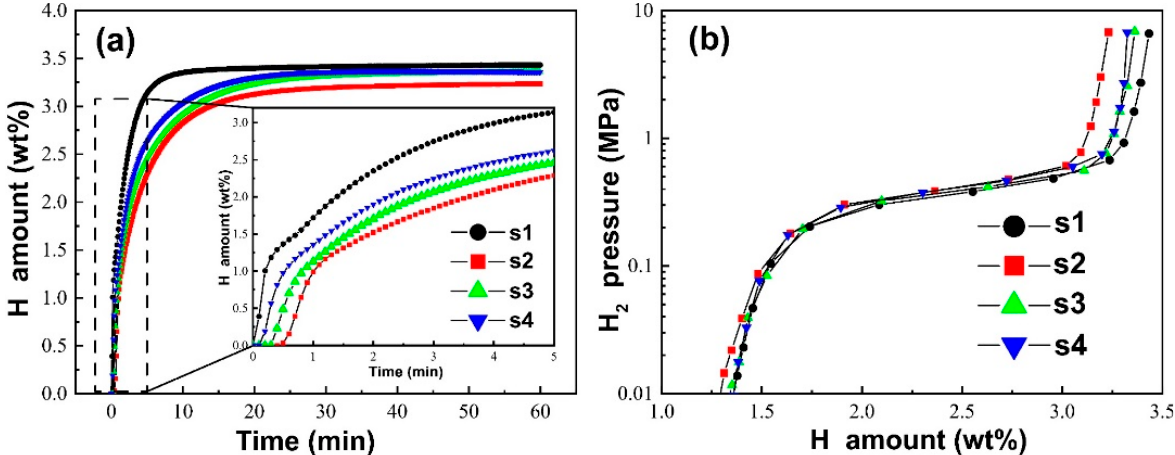
Figure 2. ( a ) Initial hydrogen absorption kinetics and ( b ) PCT plots of samples s1 to s4 during the dehydrogenation process at 298 K.